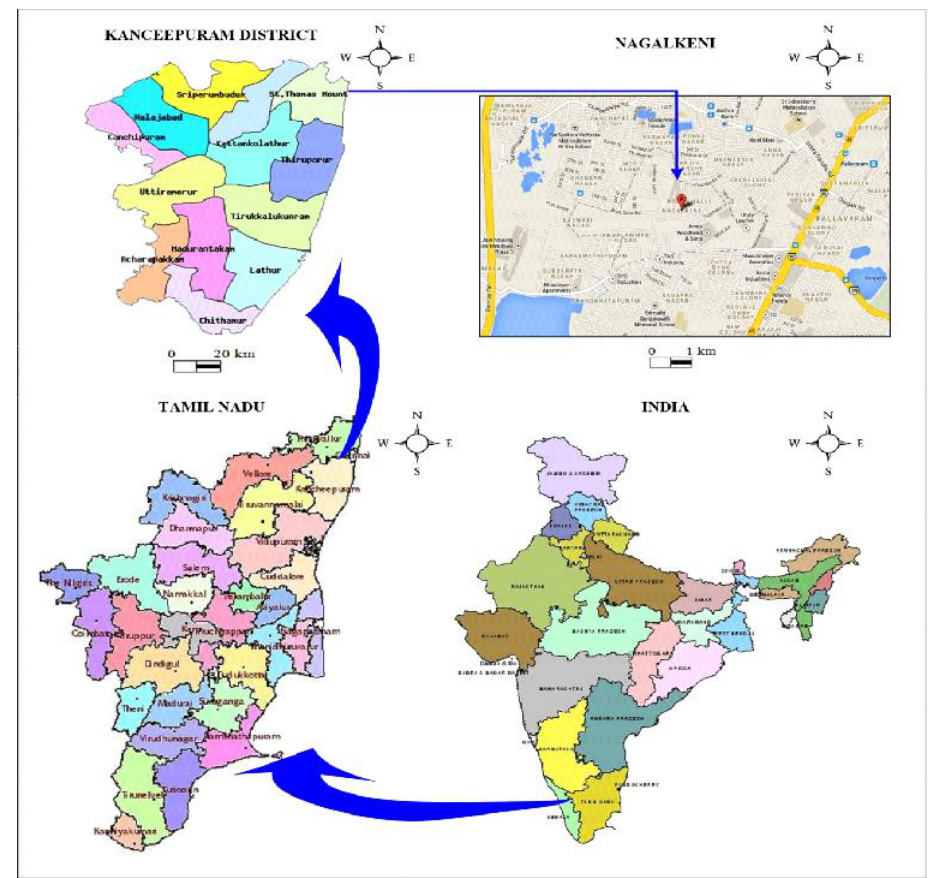
Fig. 1: Study area of